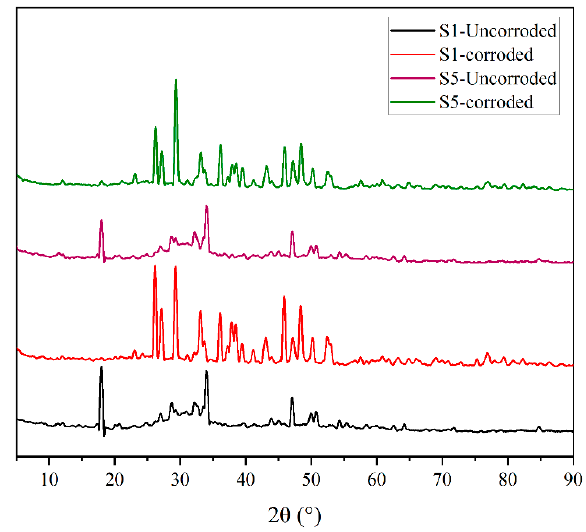
Figure 11. XRD diagram of cement slurry.